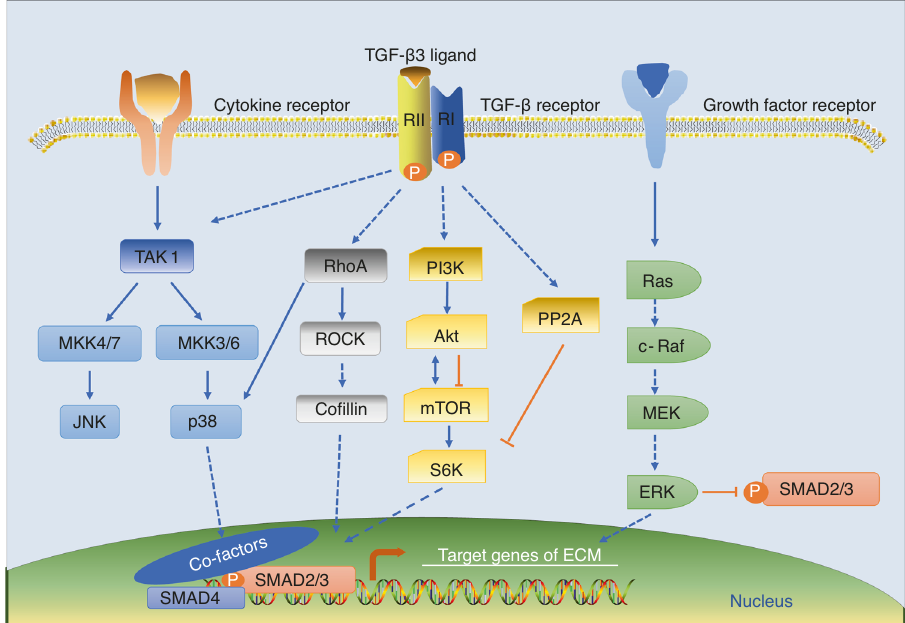
Fig. 3 Schematic diagram showing the noncanonical transforming growth factor-beta 3 (TGF- β 3) signaling pathway. TGF- β 3 activates R-Smad- independent pathways mediated by mitogen-activated protein kinases (MAPKs) (including extracellular regulated kinase (ERK), p38 kinase, and c-Jun N-terminal kinase (JNK)), phosphoinositide 3-kinase (PI3K)/protein kinase B (AKT)/mammalian target of rapamycin (mTOR), and Rho- like GTPase (Ras, RhoA, Rac1, CDC42). These pathways function independently but interact with each other to regulate cartilage development and maintenance. TAK1 transforming growth factor- β -activated kinase 1, MKK3/4/6/7 mitogen-activated protein kinase 3/4/6/7, ROCK Rho- associated protein kinase, S6K S6 kinase, PP2A protein phosphatase 2A, MEK mitogen-activated protein